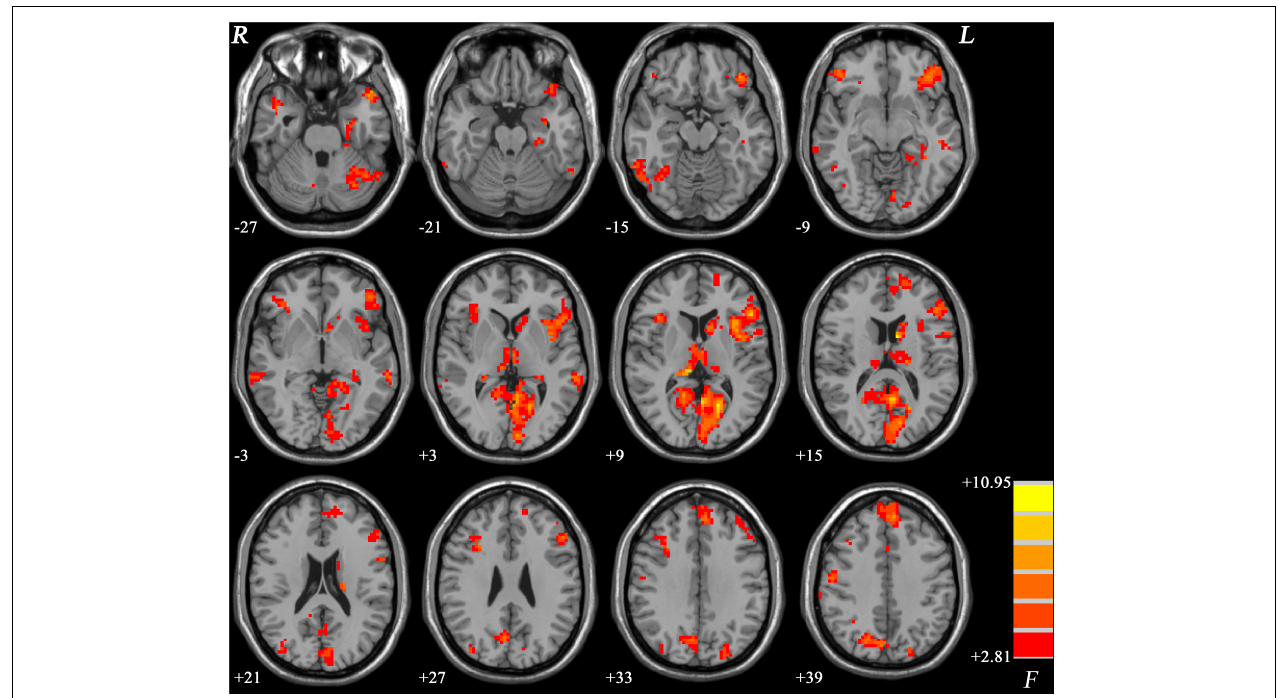
FIGURE 1 | Brain regions showing significantly different PAS scores across three groups. The color bar indicates F values based on ANCOVA. The results were FDR (false discovery rate) corrected at p < 0.05. PAS, parameter of asymmetry; ANCOVA, analysis of covariance.